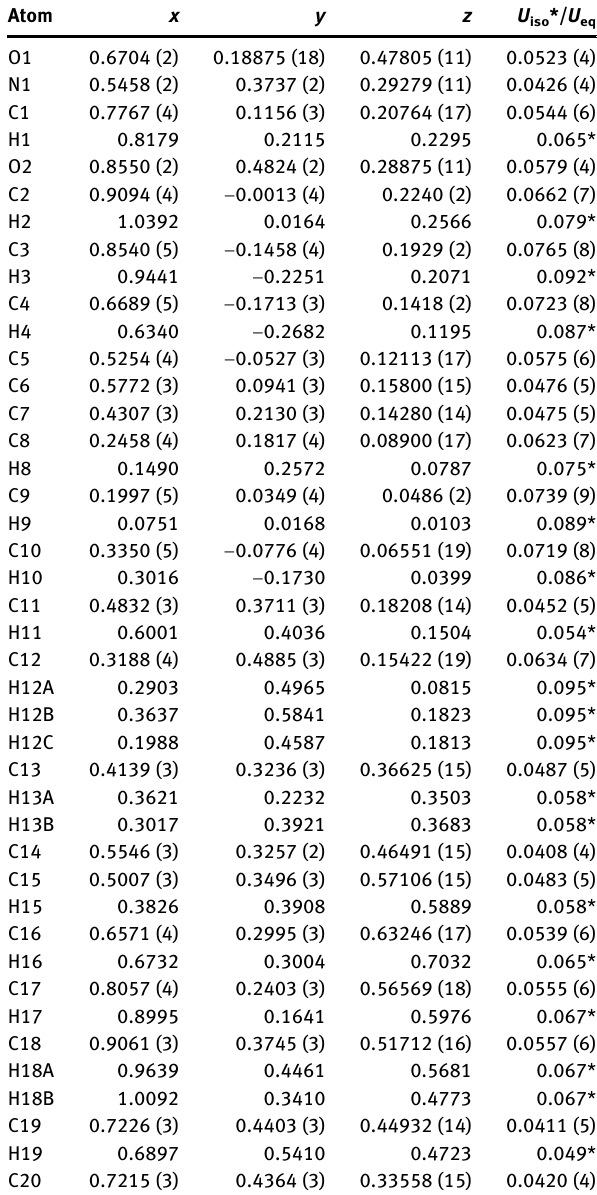
Table  : Fractional atomic coordinates and isotropic or equivalent isotropic displacement parameters (Å 